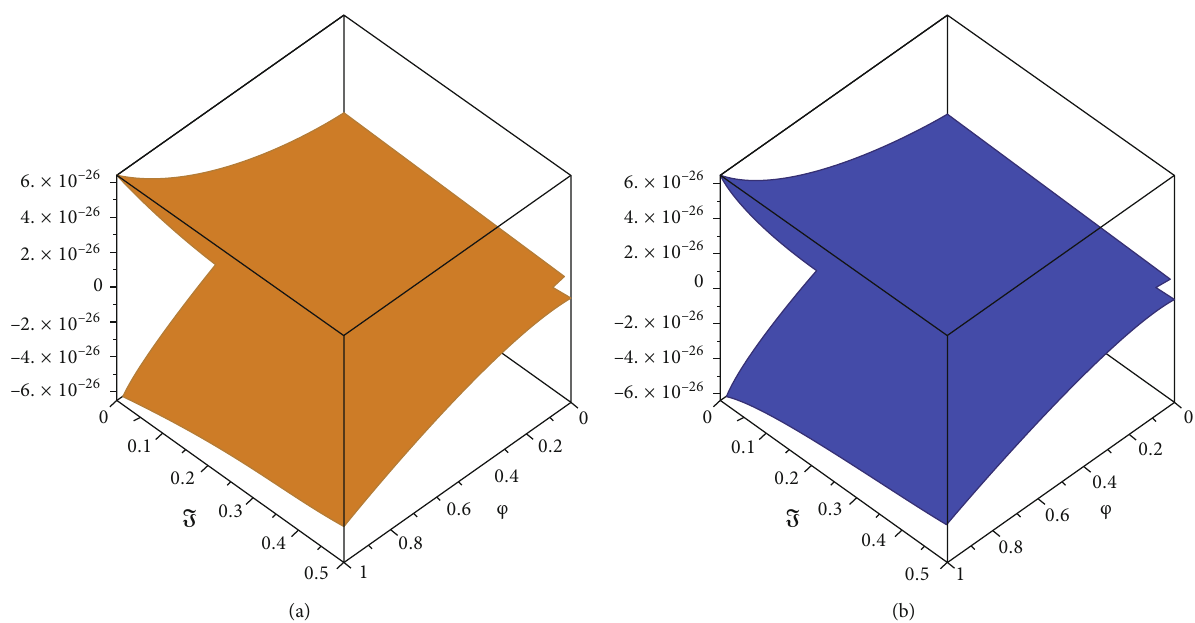
Figure 6: (a) The three-dimensional fuzzy lower and upper branch graph of approximate series result at ϱ = 0 : 6 and (b) at fractional-order of ϱ = 0 : 4